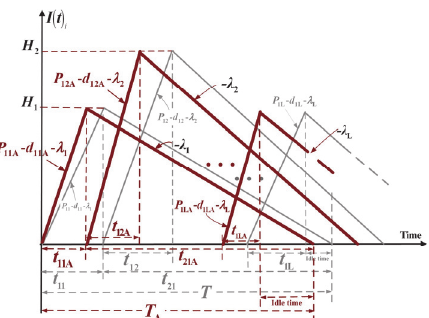
Fig. 1. Level of finished item i in the proposed FPR-based multiproduct inventory system with expedited rate and scraps (in red) as compared to the same system with standard rate (in grey)